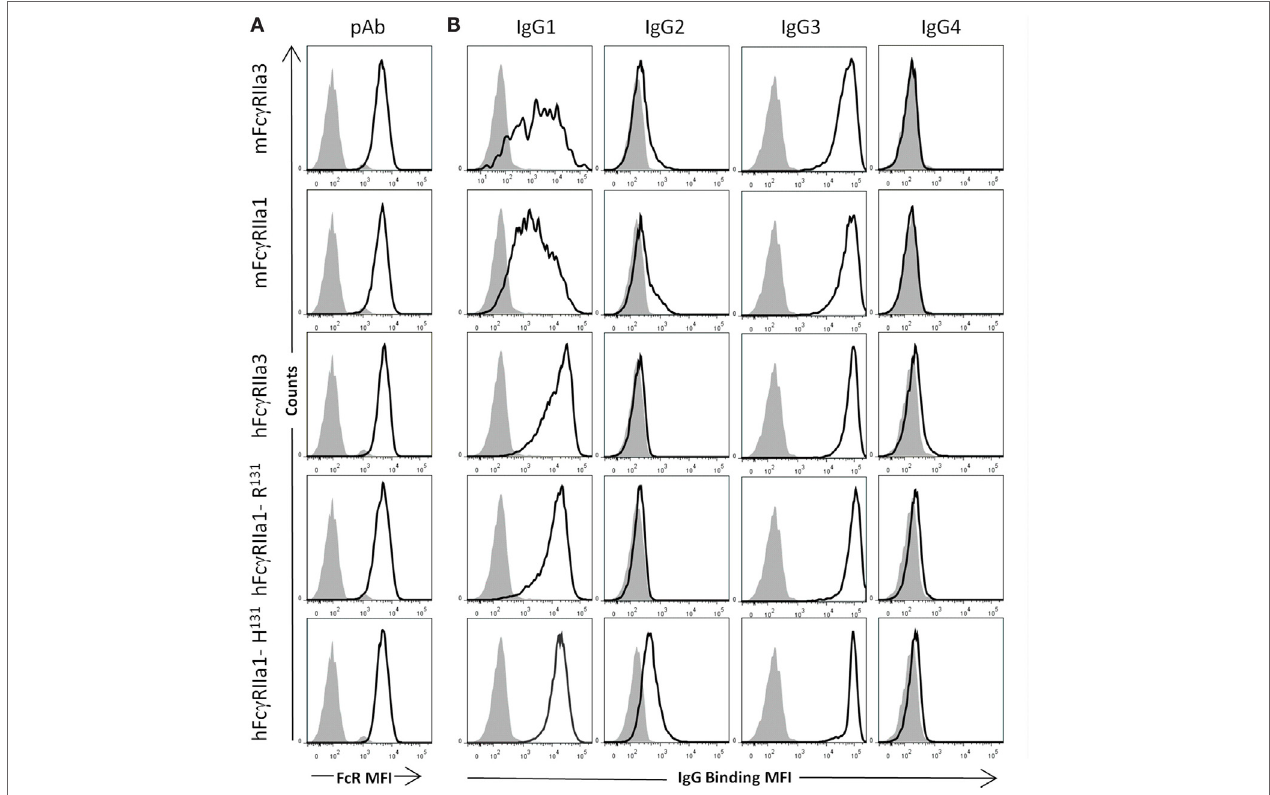
FigUre 2 | Specificity of Fc γ RII forms for human IgG subclasses. Fc γ R expression and IgG binding to IIA1.6 cells expressing macaque mFc γ RIIa3-H 131 or